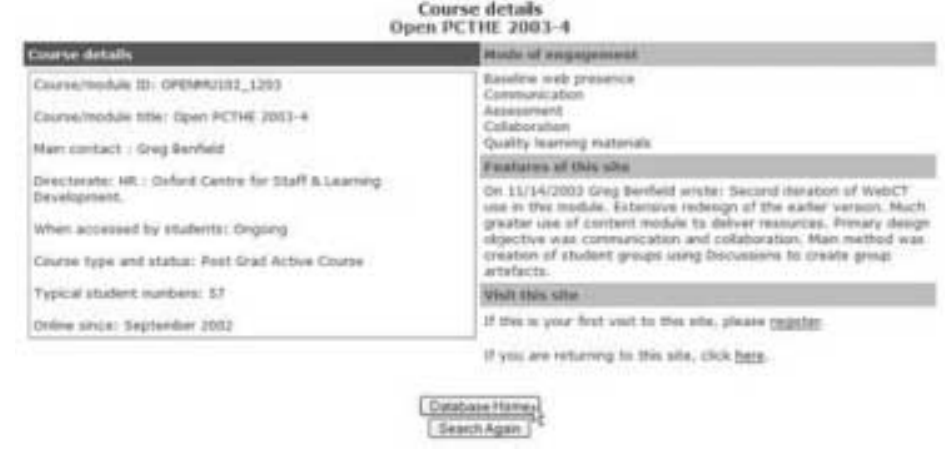
Figure 2. Example of data held about a WebCT module, including mode of engagement E-learning champions